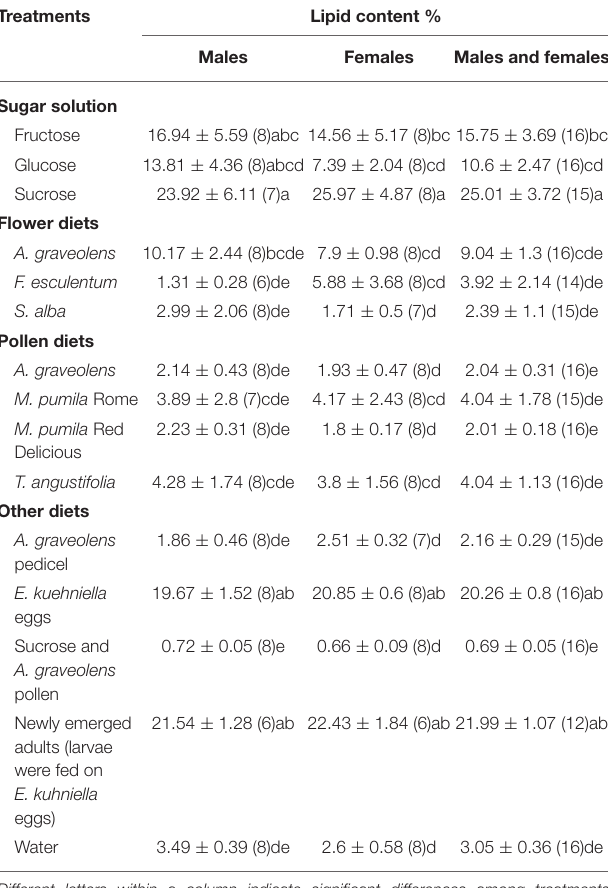
TABLE 4 | Lipid content (%) (Mean ± SE) of Adalia bipunctata adult fed on different diets.